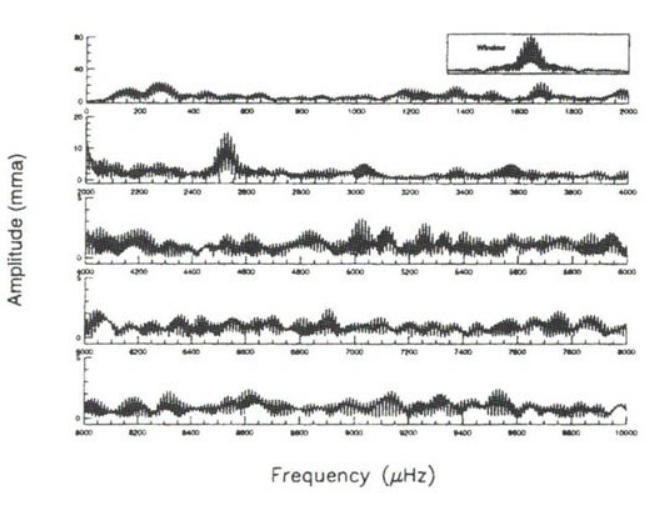
Fig. 13. The FT for the November 1991 data on G